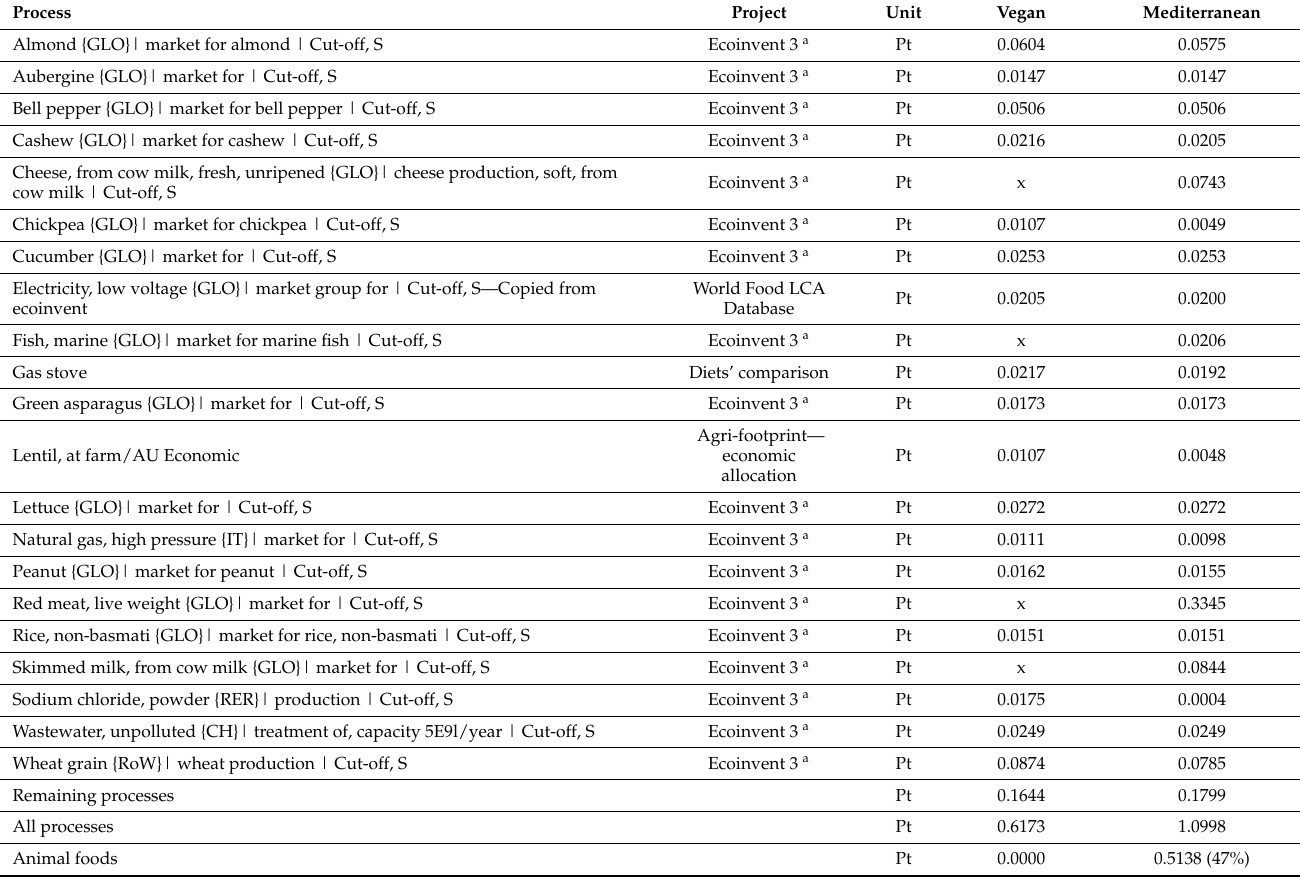
Table A1. Comparison between the contributions of the single foods in the two one-week